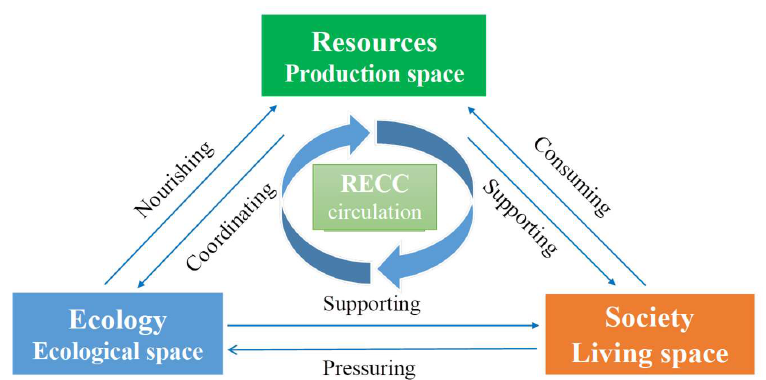
Figure 1. Research framework of the resource–environmental carrying capacity (RECC) and land space.